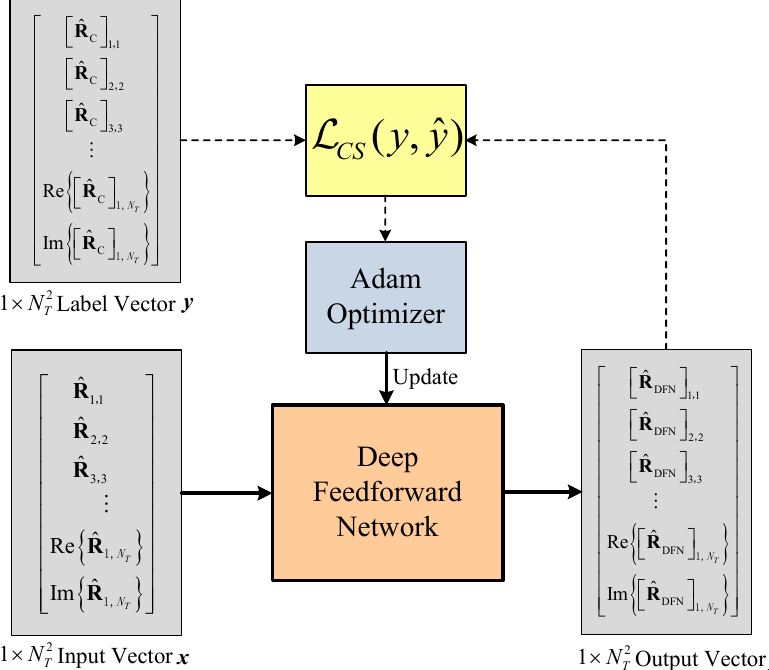
Figure 6. Block diagram of the DFN training